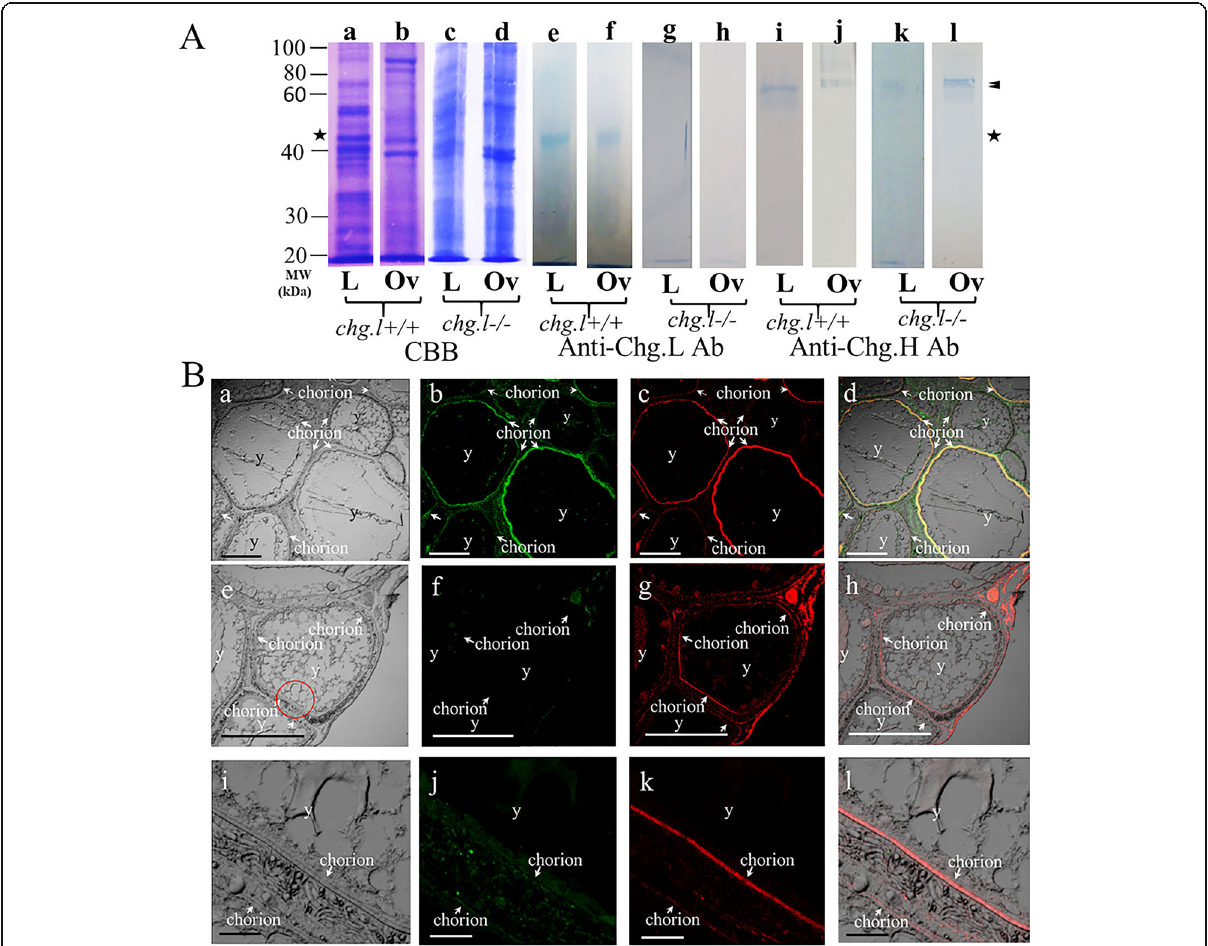
Fig. 5 Western blot analysis and IHC detection of egg envelope proteins in the ovaries of chg.l+/+ and chg.l − / − females using specific antibodies against Chgs. Panel A SDS-PAGE results showing proteins stained with CBB ( Aa-Ad ) or immunoreactive proteins with anti-medaka Chg. L ( Ae-Ah ) or Chg. H ( Ai-Al ). The numbers on the left indicate the molecular weights of the proteins (blue bands) in kilodaltons (kDa). Symbols - Arrowheasds: the position of Chg. H and Chg. Hm (corresponding to ZI-1 and -2 as chorion components). Stars: the position of Chg. L (corresponding to ZI-3 as a chorion component). No immunoreactive proteins were observed in the negative controls for the Western blot assay (i.e., with primary antibody omitted; data not shown) or the experiment (i.e., the liver and blood plasma extracts from male fish; data not shown). Abbreviations - L: liver extracts. Ov: ovary extracts. Panel B Immunohistochemical detection of egg envelope proteins in the ovaries of the chg.l+/ + and chg.l − / − females with anti-Chg.L and anti-Chg. H antibodies. Ba , Be , and Bi Transmission light micrograph of the observed ovarian oocyte in the ovary of the c hg.l+/+ female ( Ba ), ovarian egg in the ovary of the c hg.l − / − female ( Be ), and magnified portion in Be circled with red ( Bi ). Bb , Bf , and Bj Immunoreactivity with anti-Chg.L antibodies in the same ovarian oocyte as shown in Ba , Be , and Bi , respectively. Bc , Bg , and Bk Immunoreactivity with anti-Chg.H antibodies in the same ovarian oocyte as Ba , Be , and Bi , respectively. Bd Transmission light micrograph ( Ba ) overlaid with Bb and Bc . Bh Transmission light micrograph ( Be ) overlaid with Bf and Bg . Bl Transmission light micrograph ( Bi ) overlaid with Bj and Bk . Symbol - White arrows: position of the chorion. Abbreviation - y: yolk. Scale bars represent 500 μ m ( Ba , Bb , Bc , Bd , Be , Bf , Bg , Bh ) and 50 μ m ( Bi , Bj , Bk , Bl